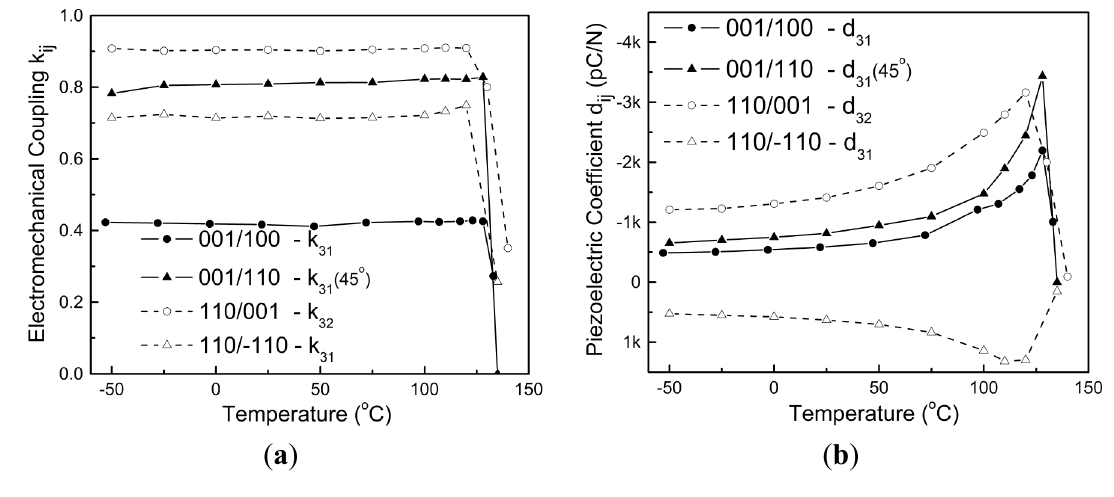
Figure 7. Transverse electromechanical coupling k function of temperature for <001>- and <110>-poled crystals. Reprinted with permission from [69]. Copyright 2009 AIP